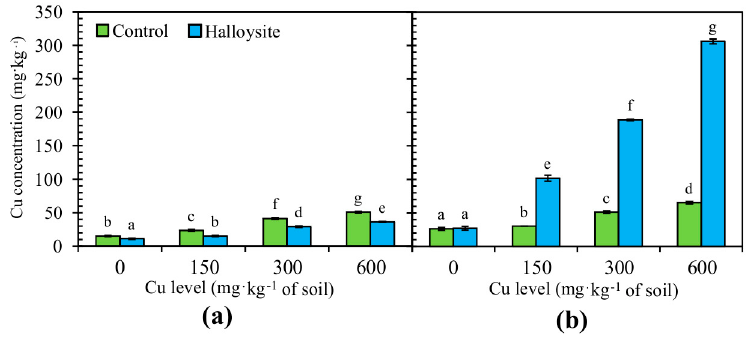
Figure 3. Copper concentration (mg · kg − 1 , dry weight basis) in the above-ground part ( a ) and roots ( b ) of F. rubra at the end of the trial. Error bars are ± standard error ( n = 3). Bars marked with different letters differ significantly for the same Cu exposure ( p < 0.05) according to the Duncan test.